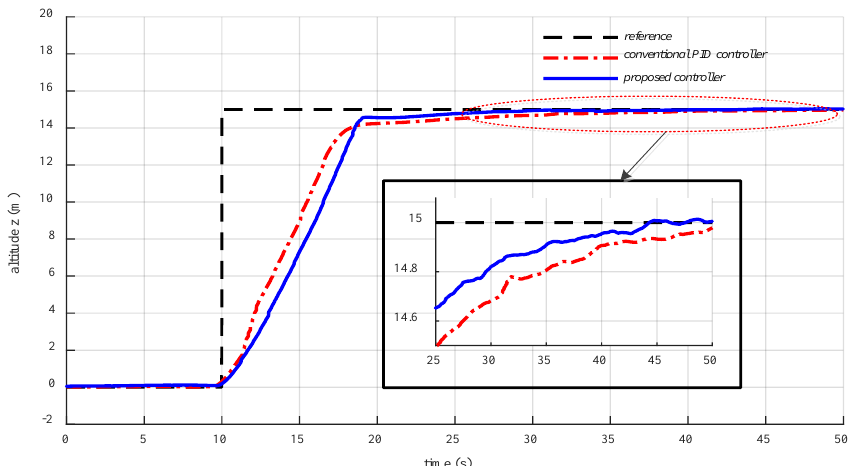
Figure 14. Comparison of experimental altitude performance between our new controller and a conventional PID controller.